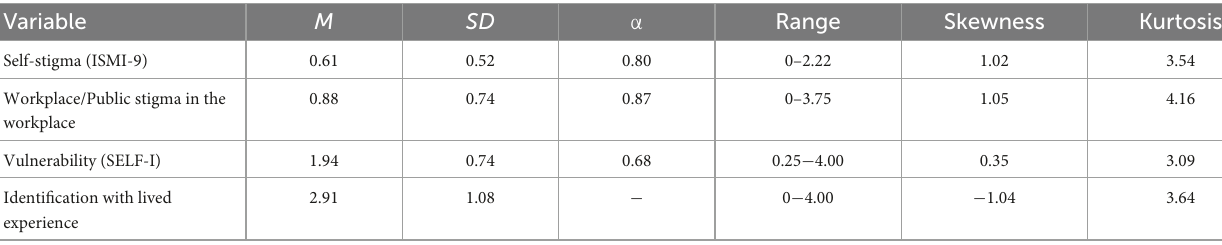
TABLE 2 Psychometric properties of study variables.